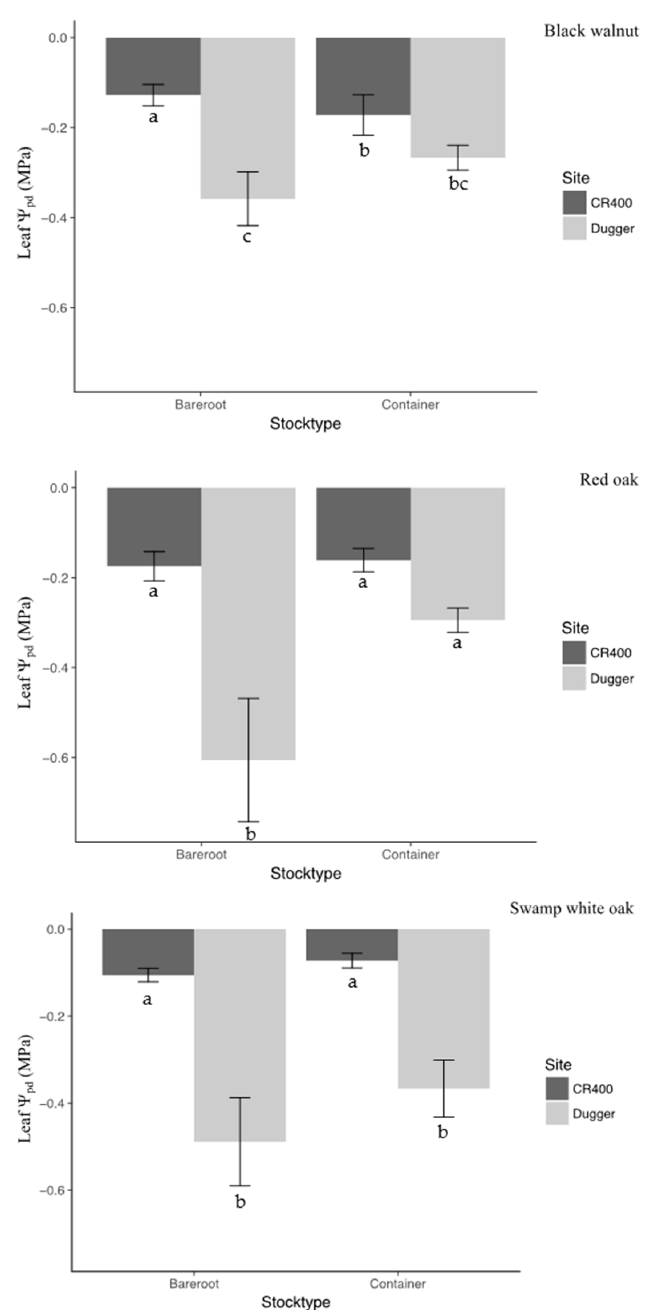
Figure 5. Mean leaf pre-dawn water potential ( Ψ pd ) for each site and stocktype. Columns are means, and error bars are (±SE). Columns with different letters are statistically different according to Tukey’s Honestly Significant Difference (HSD) test at α = 0.05.